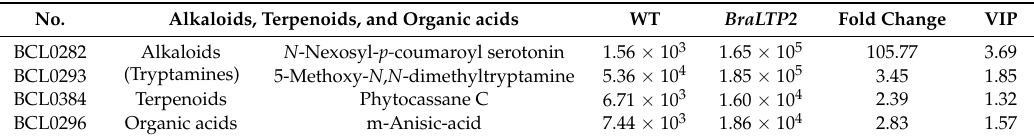
Table 6. Difference of alkaloids, terpenoids, and organic acids in the wild type and 35::BraLTP2 - overexpressed lines.